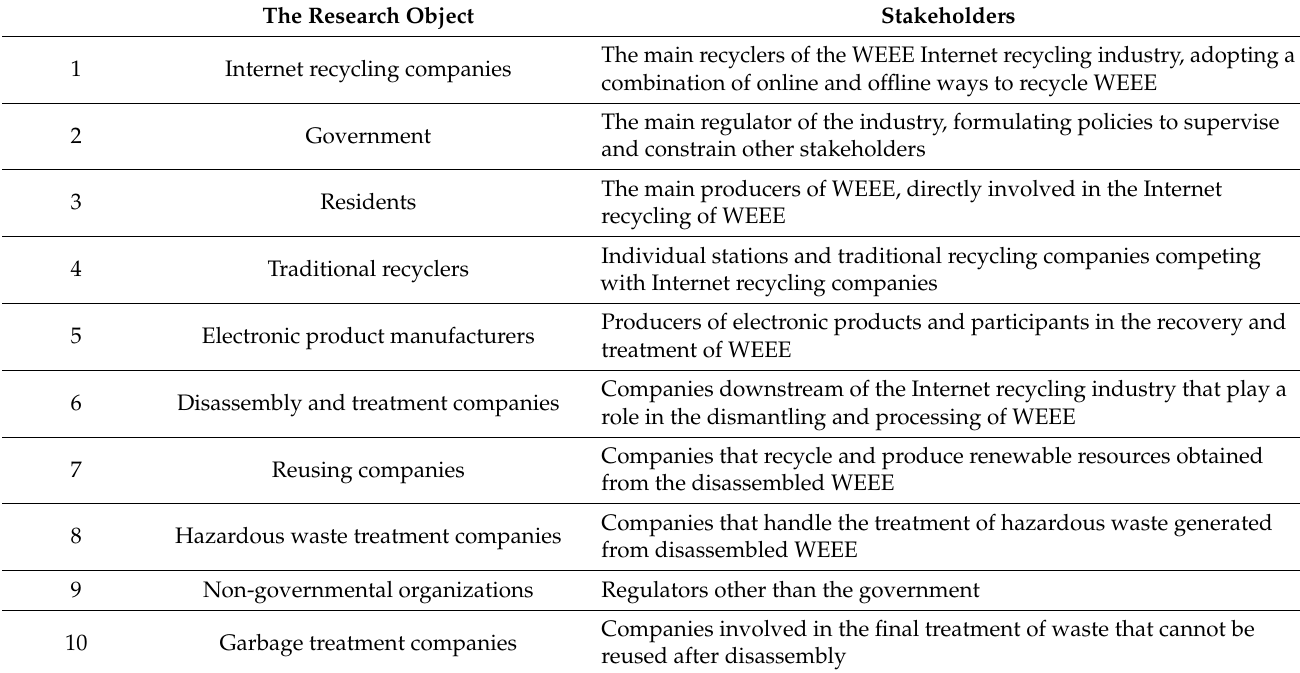
Table 2. WEEE internet recycling